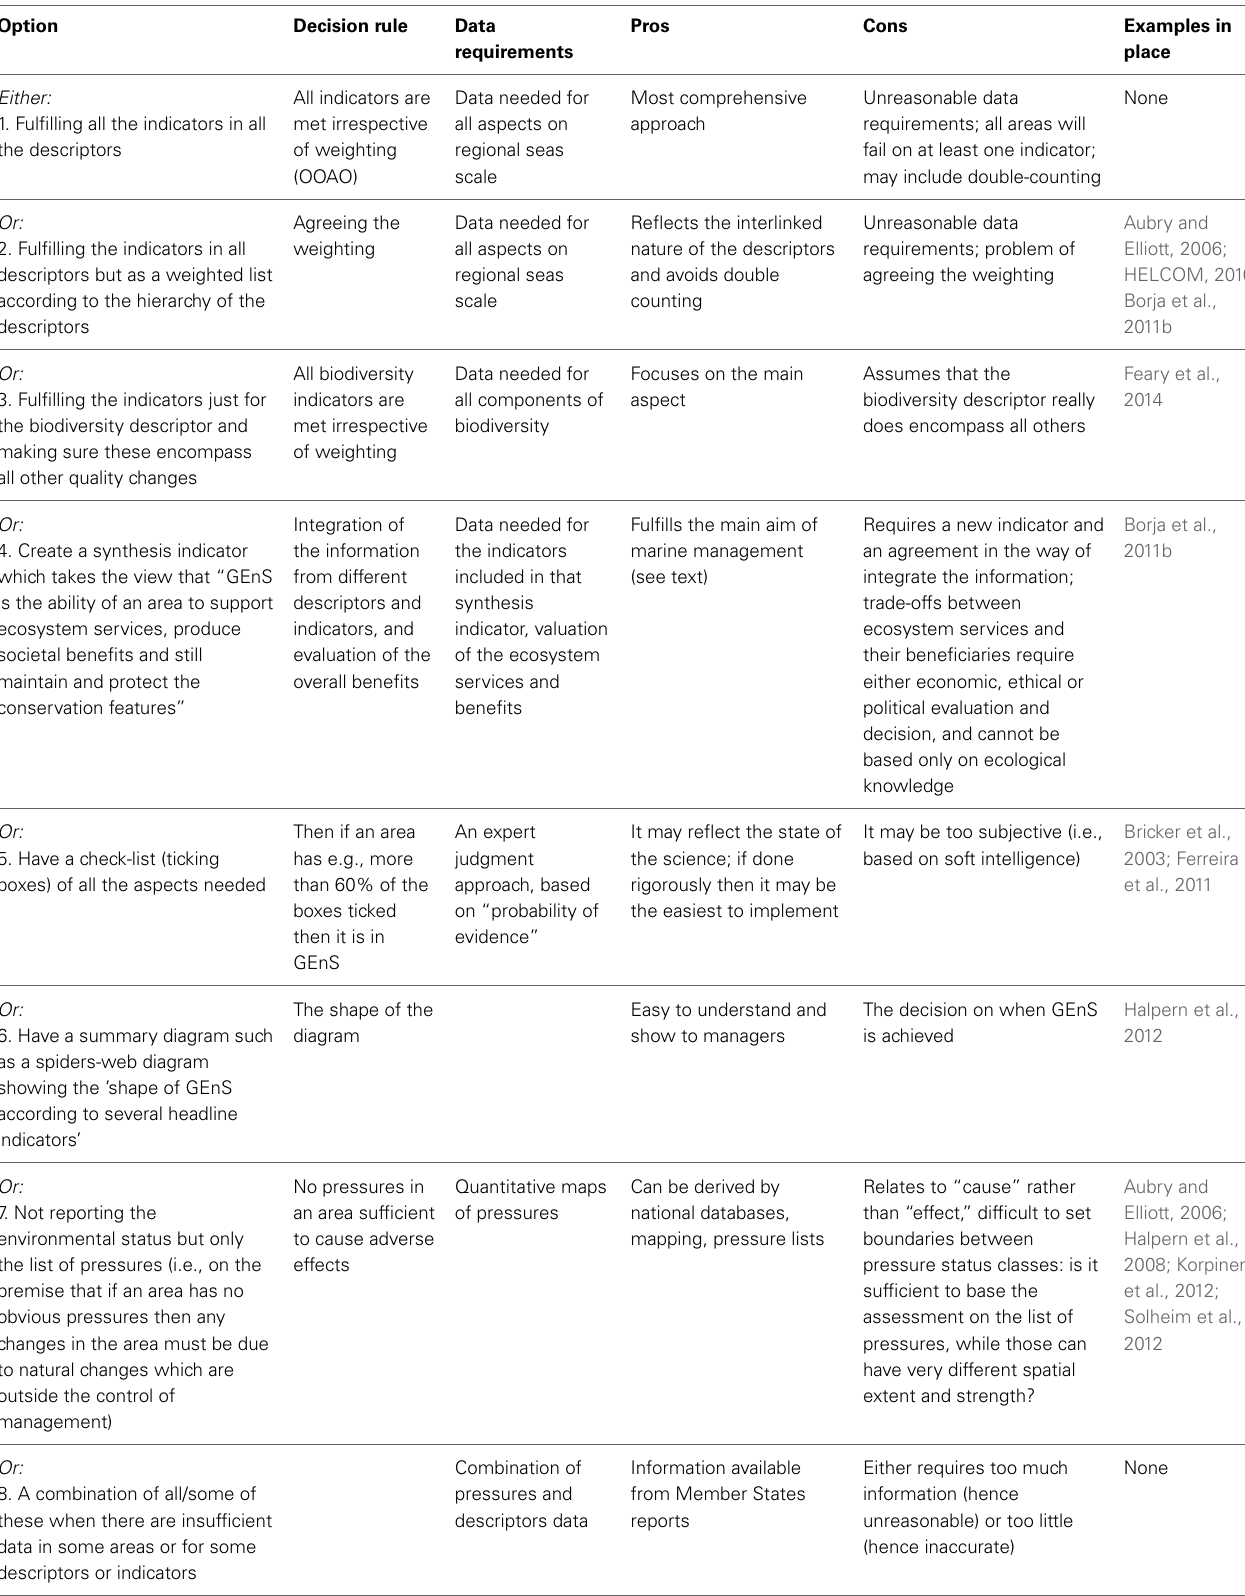
Table 4 | Options for determining if an area/regional sea is in Good Environmental Status (GEnS) (modified from Borja et al.,